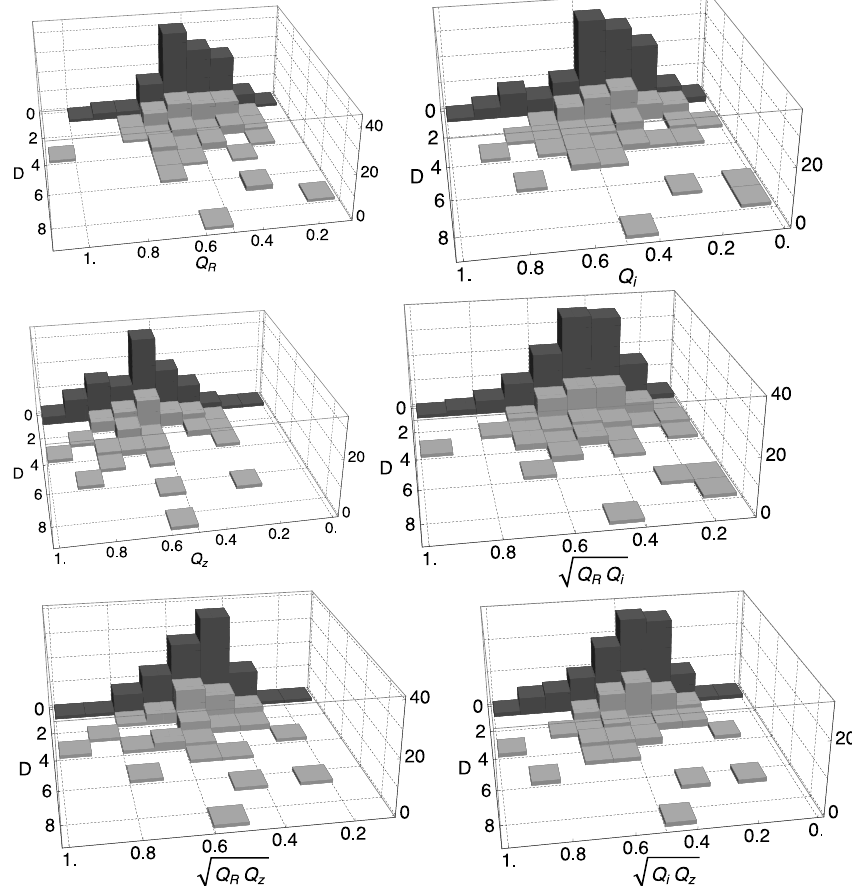
Figure 10. Histograms showing the disagreement factor (difference in the measurements divided by the sum the of errors) between Spirality and 2DFFT for galaxies in GOODS North and South. The disagreement factor D indicates the trustworthiness of the codes’ error bars. In each panel, dark gray histogram bars show galaxies for which D < 1, i.e., for which Spirality’s pitch angle measurement is consistent with 2DFFT’s measurement within the error bars. The light gray histogram bars show galaxies for which the codes disagree. The second independent variable is different for each panel. Top left: Radius quality, which is the galaxy’s angular radius in pixels, scaled logarithmically such that its value for the largest galaxy is approximately unity. Top right: Brightness quality, which is the i -band magnitude, scaled linearly such that its value for the brightest galaxy is approximately unity and for the dimmest galaxy is approximately zero. Middle left: Distance quality, which is the redshift scaled linearly such that its value for the nearest galaxy approaches unity and for the most distant galaxy approaches zero. Middle right: Geometric mean of radius quality and brightness quality. Bottom left: Geometric mean of radius quality and distance quality. Bottom right: Geometric mean of brightness quality and distance